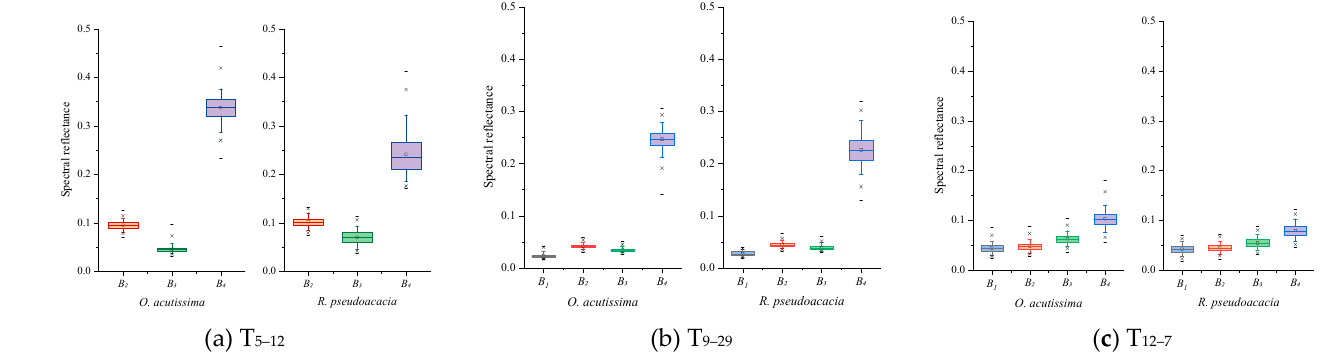
Figure 2. Spectral reflectance of each band at different phenological phases.